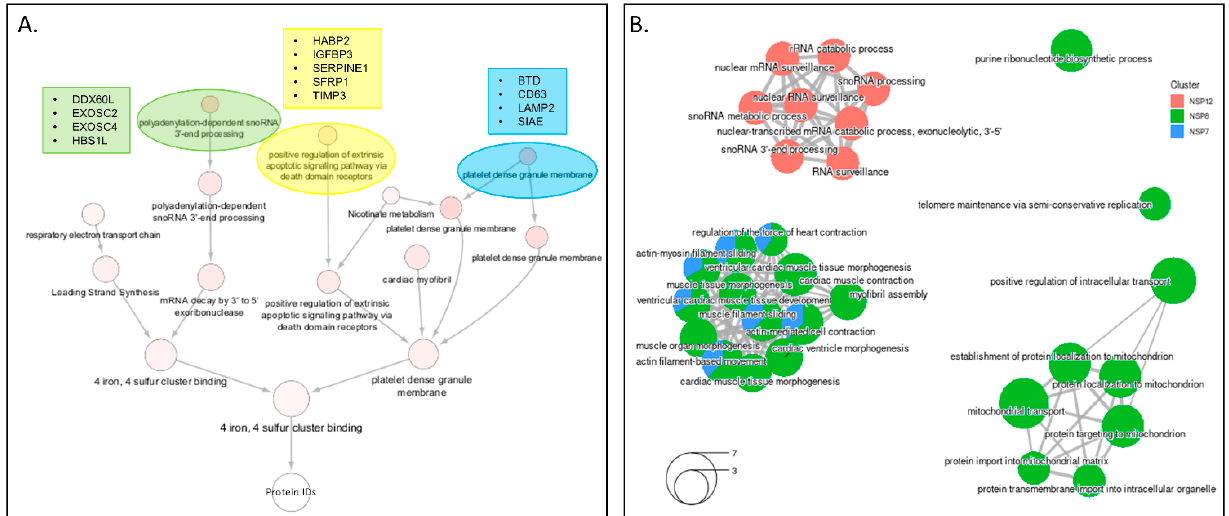
Figure 6. Integrated bioinformatics analysis of datasets from cells expressing individual RDRP-complex viral proteins. ( A ) The network containing the 123 proteins identified as NSP7/8/12 unique interactors, globally upregulated, or globally downregulated was subjected to supervised community detection and the resulting hierarchy is shown. Each node represents a cluster of interconnected proteins and each edge (marked by an arrow) represents containment of one community (target) by another (source). Indicated are enriched biological processes as determined by gProfiler. ( B ) Gene ontology enrichment of biological processes performed by unique host-proteins identified in proximity labeling studies for NSP7/8/12.